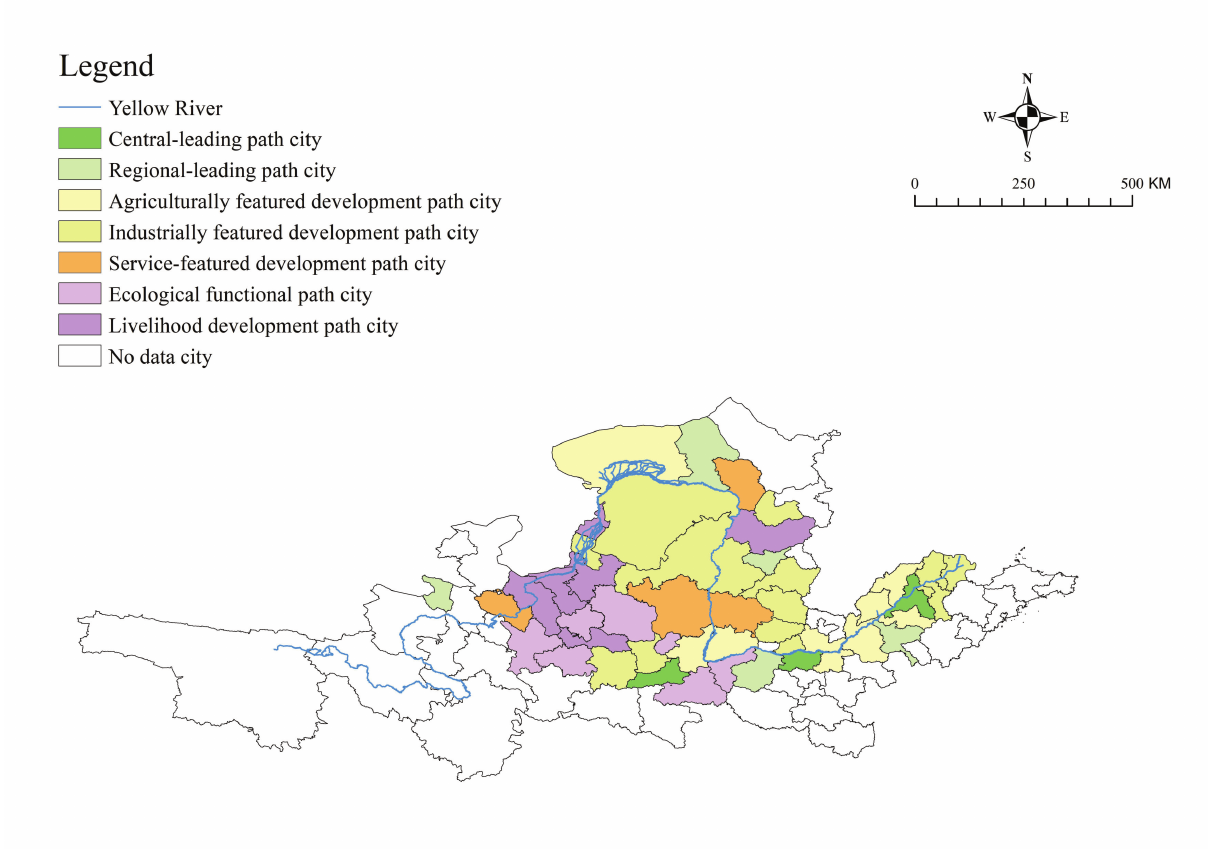
Figure 5. Map of suitability path selection of the high-quality development of YRB